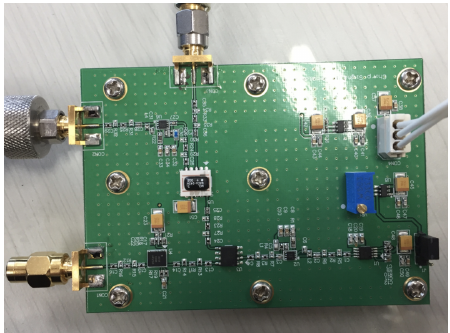
Figure 4. Assembled chirp signals generator; first version of RF board.